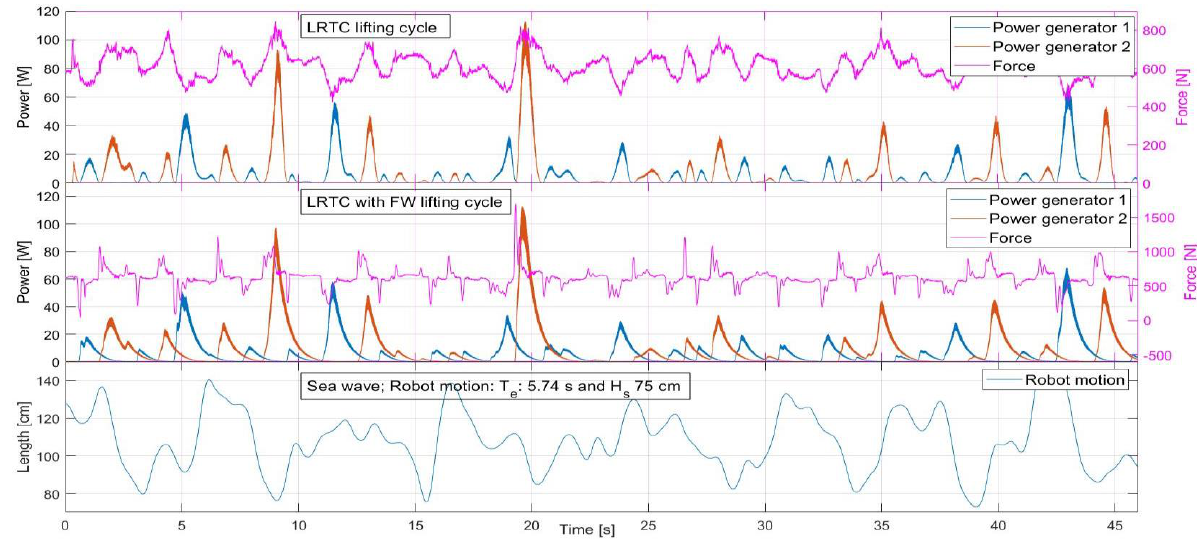
Fig. 12. The LRTC lifting cycle series for Exp. II.2a and 2b. Sea wave motion with Hs = 0.75 m and Te = 5.74